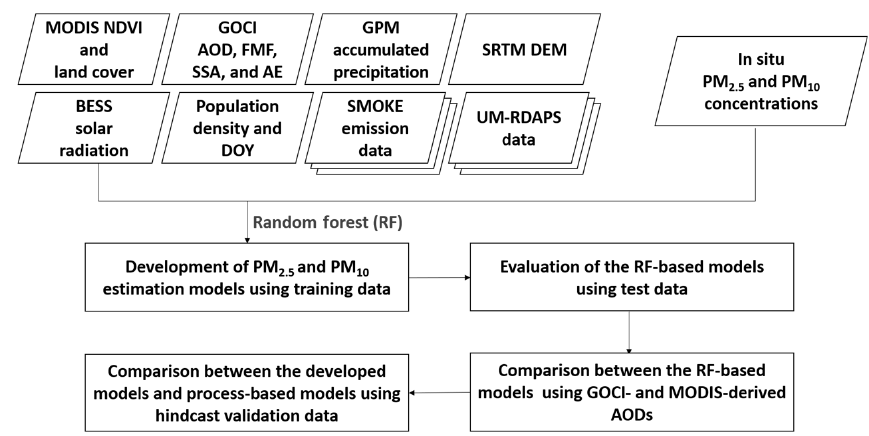
Figure 2. Process flow diagram of the estimation of ground-level particulate matter concentrations proposed in this study. Table 4. Accuracy assessment results of the RF-based models for estimating PM concentrations using the test datasets during 2015–2016. R 2 RMSE a rRMSE b MB c ME d Slope Intercept (µgm − 3 ) (%) (µgm − 3 ) (µgm − 3 ) Model (with original training samples) PM 10 0.58 24.34 Improved model (with balanced training samples) PM